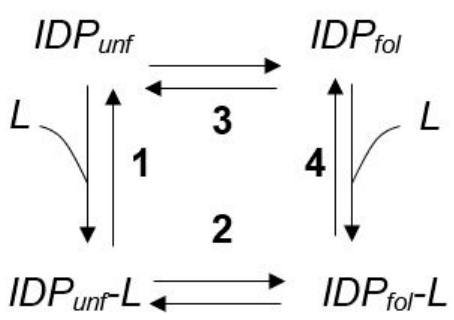
Scheme 1. Schematic representation of the overall reaction mechanism involving the binding between an IDP and its ligand.